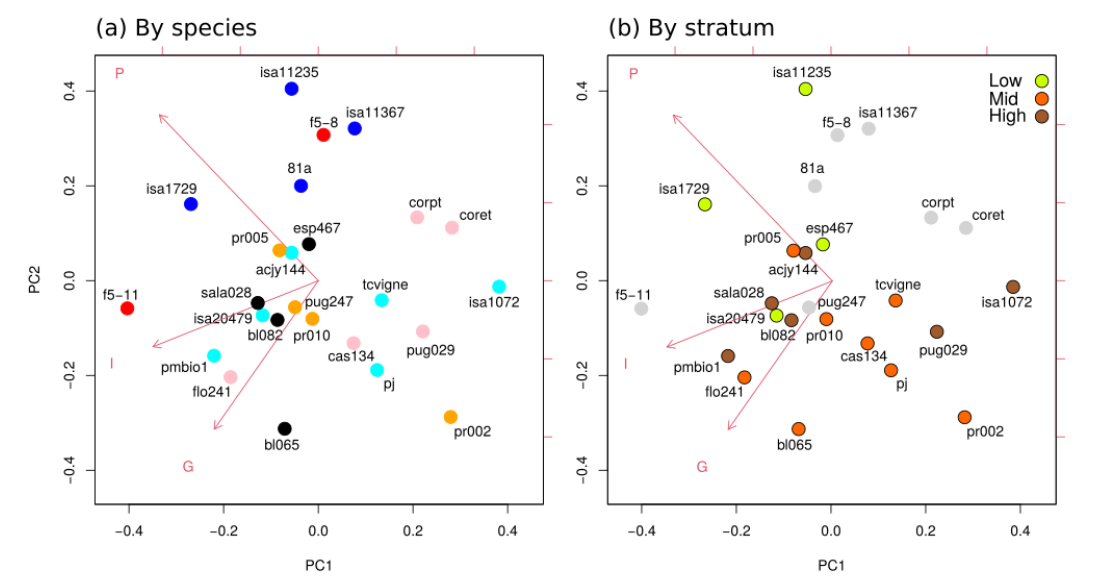
Figure 5. PCA representing all 25 populations based on their three oviposition preference scores (“P”, “G” and “I” treatments). The three variables are represented by the three red vectors. PC1 and PC2 captured 51% and 43% of the total variance, respectively (see Table S1 in S.I.). Populations are colored according to (a) species (see Table 1 and previous figures for color code) and (b) the vegetation strata in which they were sampled. In (b) grey circles are populations without stratum data